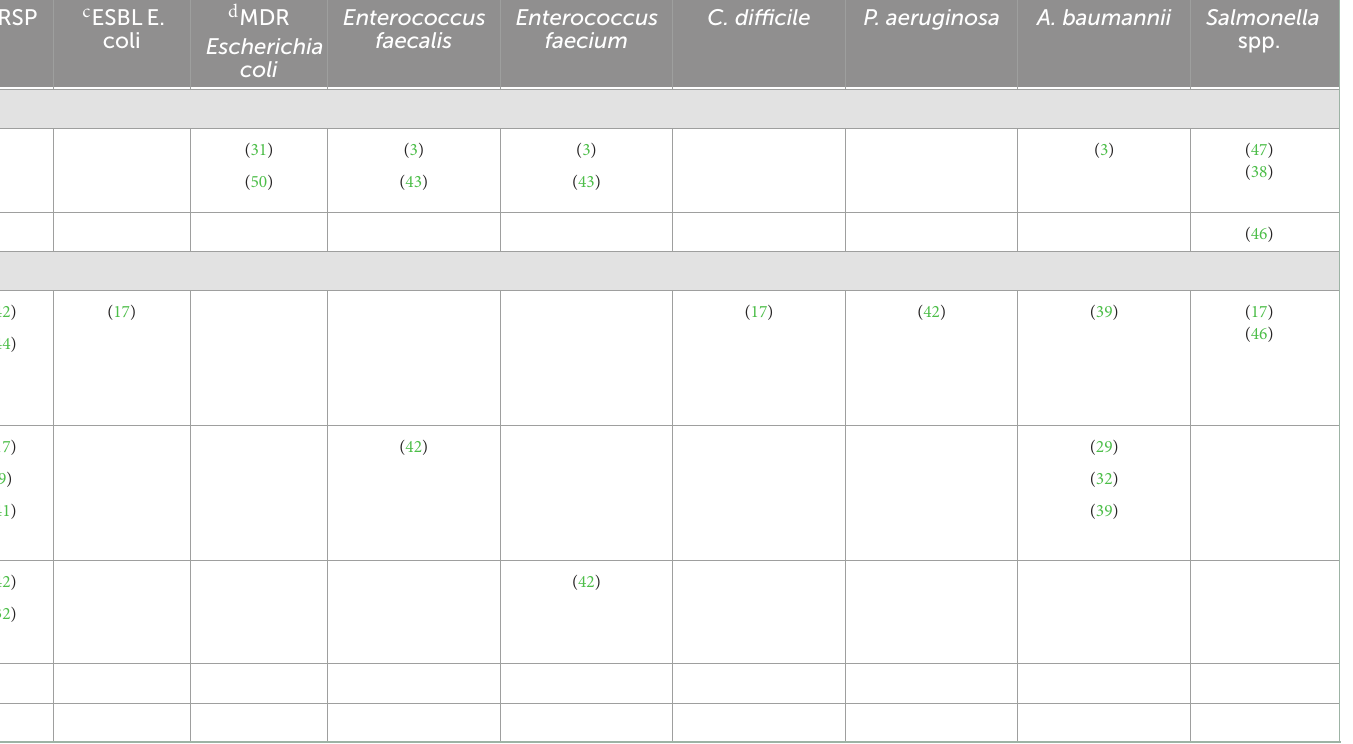
TABLE 4 Sources of hospital acquired organisms based on the systematic reviewed papers published from 2000 to